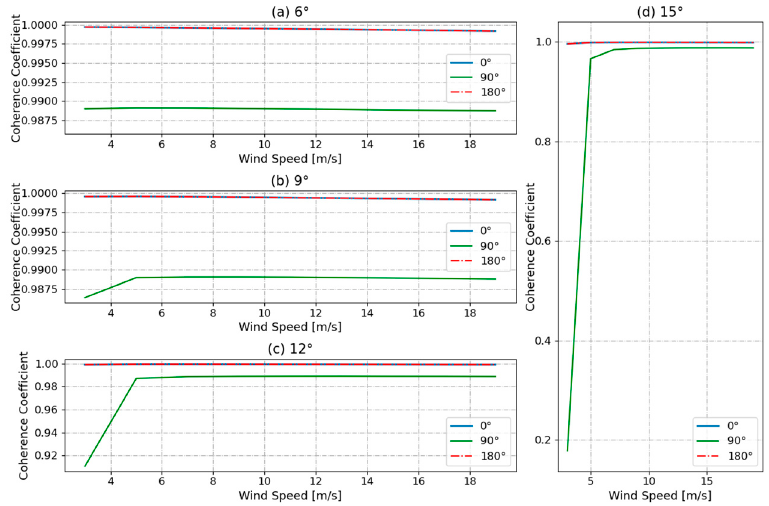
Figure 8. At 0°, 90°, and 180° azimuth angles, the coherence coefficient of pulse pairs varies with the Figure 8. At 0 ◦ , 90 ◦ , and 180 ◦ azimuth angles, the coherence coefficient of pulse pairs varies with the wind speed (3~19 m/s); the wind direction is 0°, and there is no swell. wind speed (3~19 m/s); the wind direction is 0 ◦ , and there is no